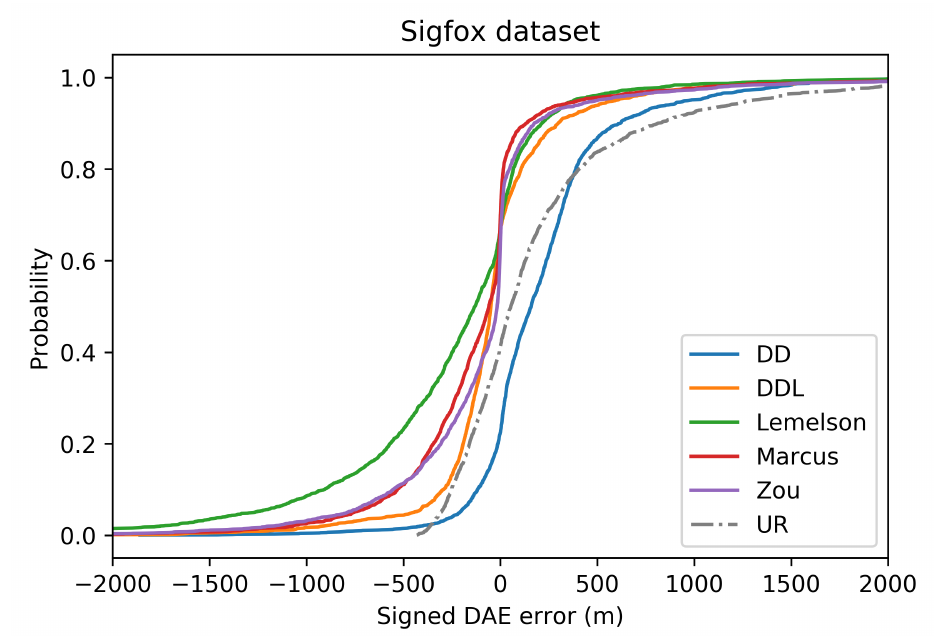
Figure 5. The Cumulative Distribution Function (CDF) of the signed DAE error (in meters) for all studied methods and one baseline, in the validation set of the Sigfox dataset. Negative values correspond to DAE overestimating the error (“ground-truth position inside the DAE circle”), while positive values correspond to DAE underestimating the error (“ground-truth position outside the DAE circle”).